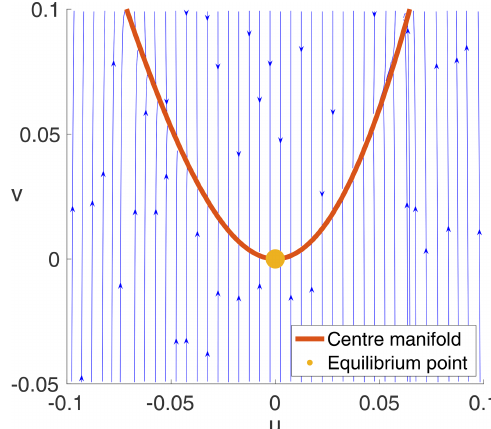
Figure 2. Phase portrait of system Eq. (15), together with a portion of the centre manifold (in red), in the ( u,v ) eigenbasis coordinates. Parameter values are those at the computed cusp point. The yellow dot marks the cusp equilibrium point. Note the rapid approach to the centre manifold from initial points not on the centre manifold in contrast to the slow evolution along the centre